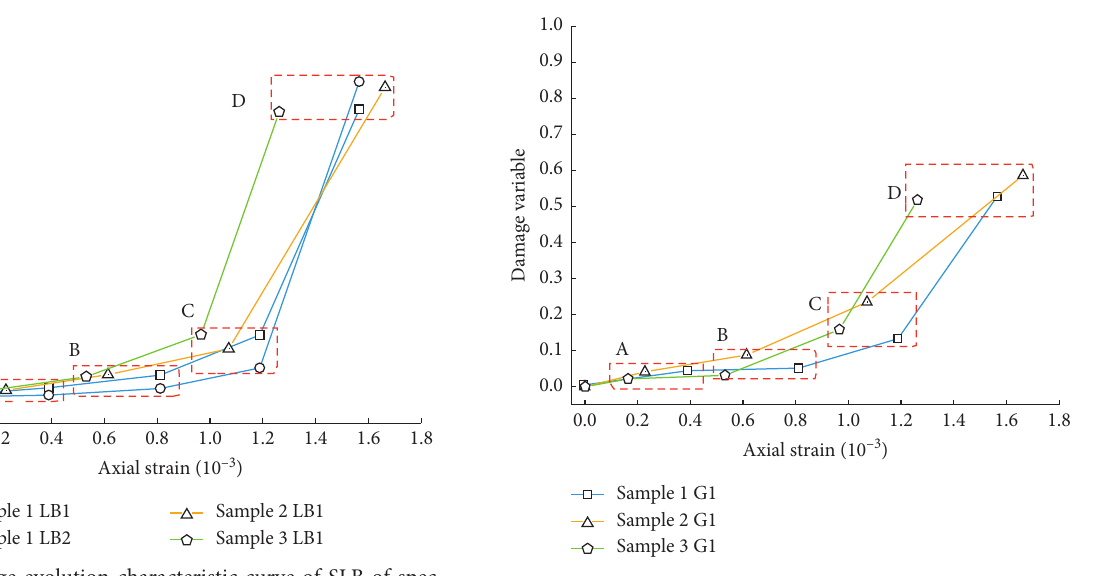
Figure 9: Damage evolution characteristic curve of whole speci- mens S 1, S 2, and S 3. Table 3: Evolution process of damage variable of samples S 1– S 3.